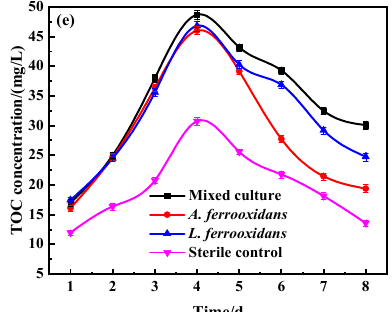
Figure 1. Variations in the ( a ) pH; ( b ) Eh; ( c ) total Fe concentration; ( d ) As leaching rate; ( e ) TOC concentration over time during the oxidation process of DRGO.